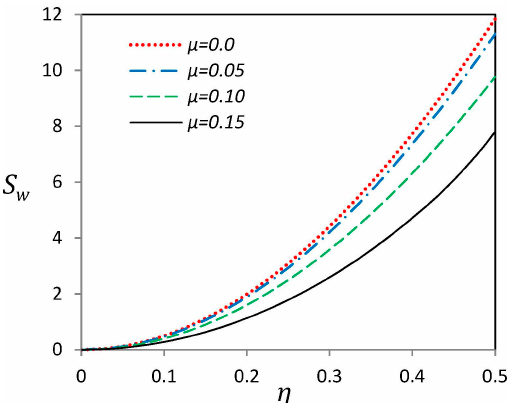
Figure 7. Effect of nonlocal parameter μ on sensitivity indicator of a nano-beam with “G” type initial imperfection with hinged-hinged endpoint conditions.